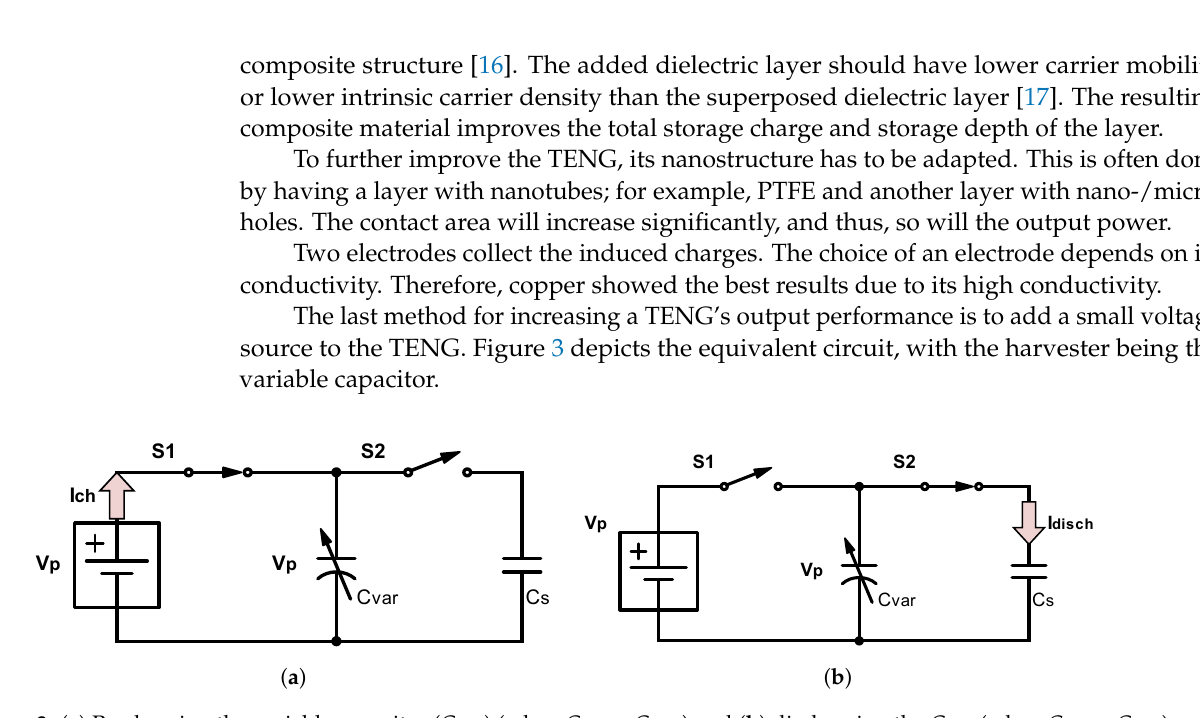
Figure 3. ( a ) Precharging the variable capacitor ( C Var ) (when C Var = C max ) and ( b ) discharging the C Var (when C Var = C min ) to a storage capacitor (C s ) [18].